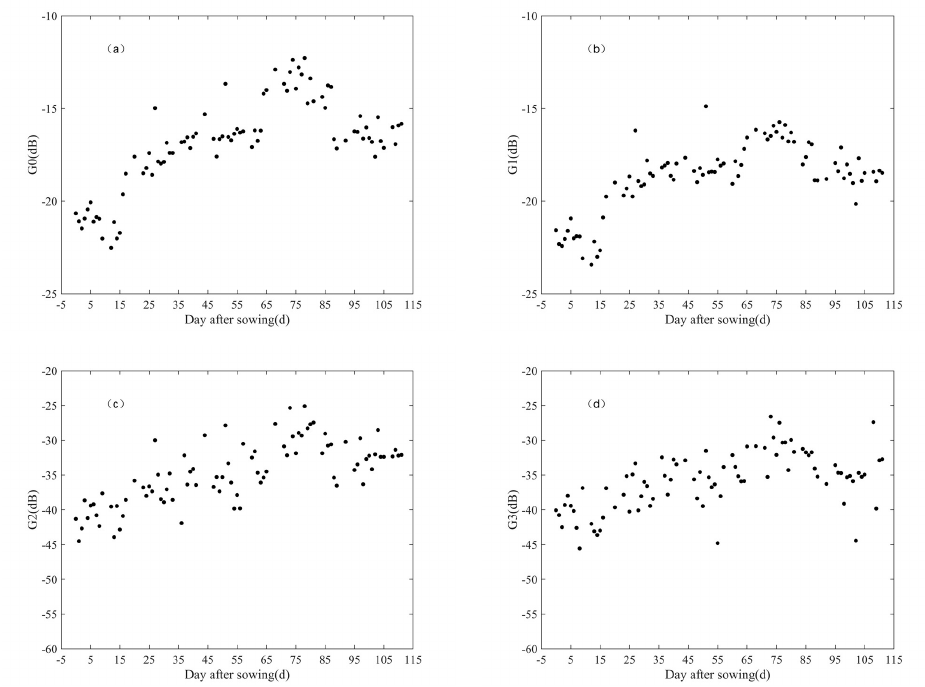
Figure 4. Evolution of the Group1 Stokes parameters versus oilseed rape phenology.